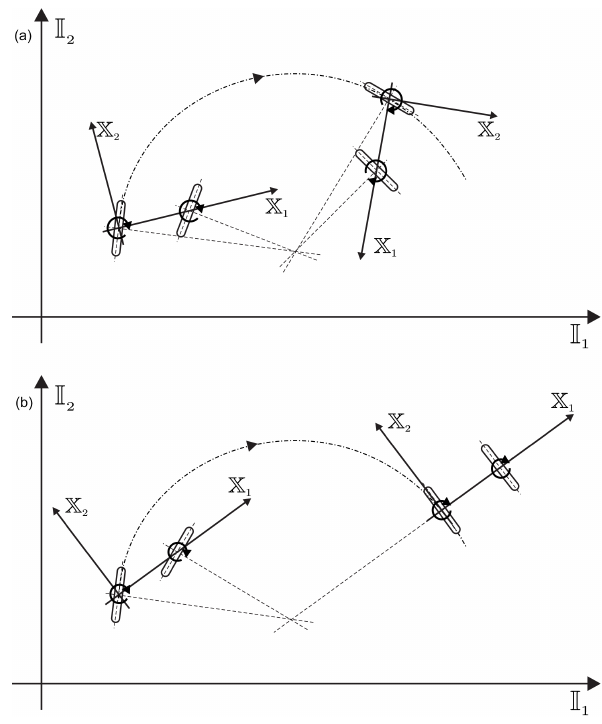
Figure 6. (a) Circular motion of a HW-type Vb WMR with constant steering angles. (b) Circular motion of a HW-type Vb WMR with constant